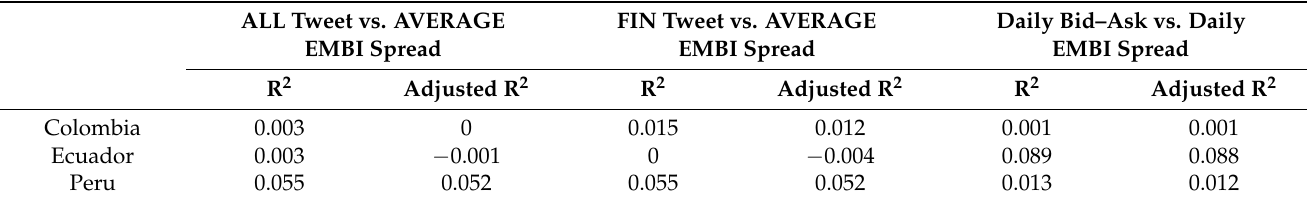
Table 6. Larger Datasets *.